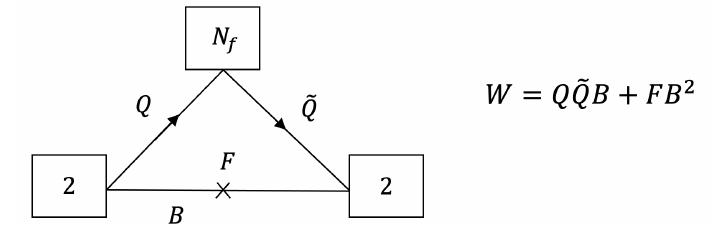
Figure 1 . The 3 d model corresponding to the compactification of the 5 d Seiberg E N tube with two maximal punctures and flux